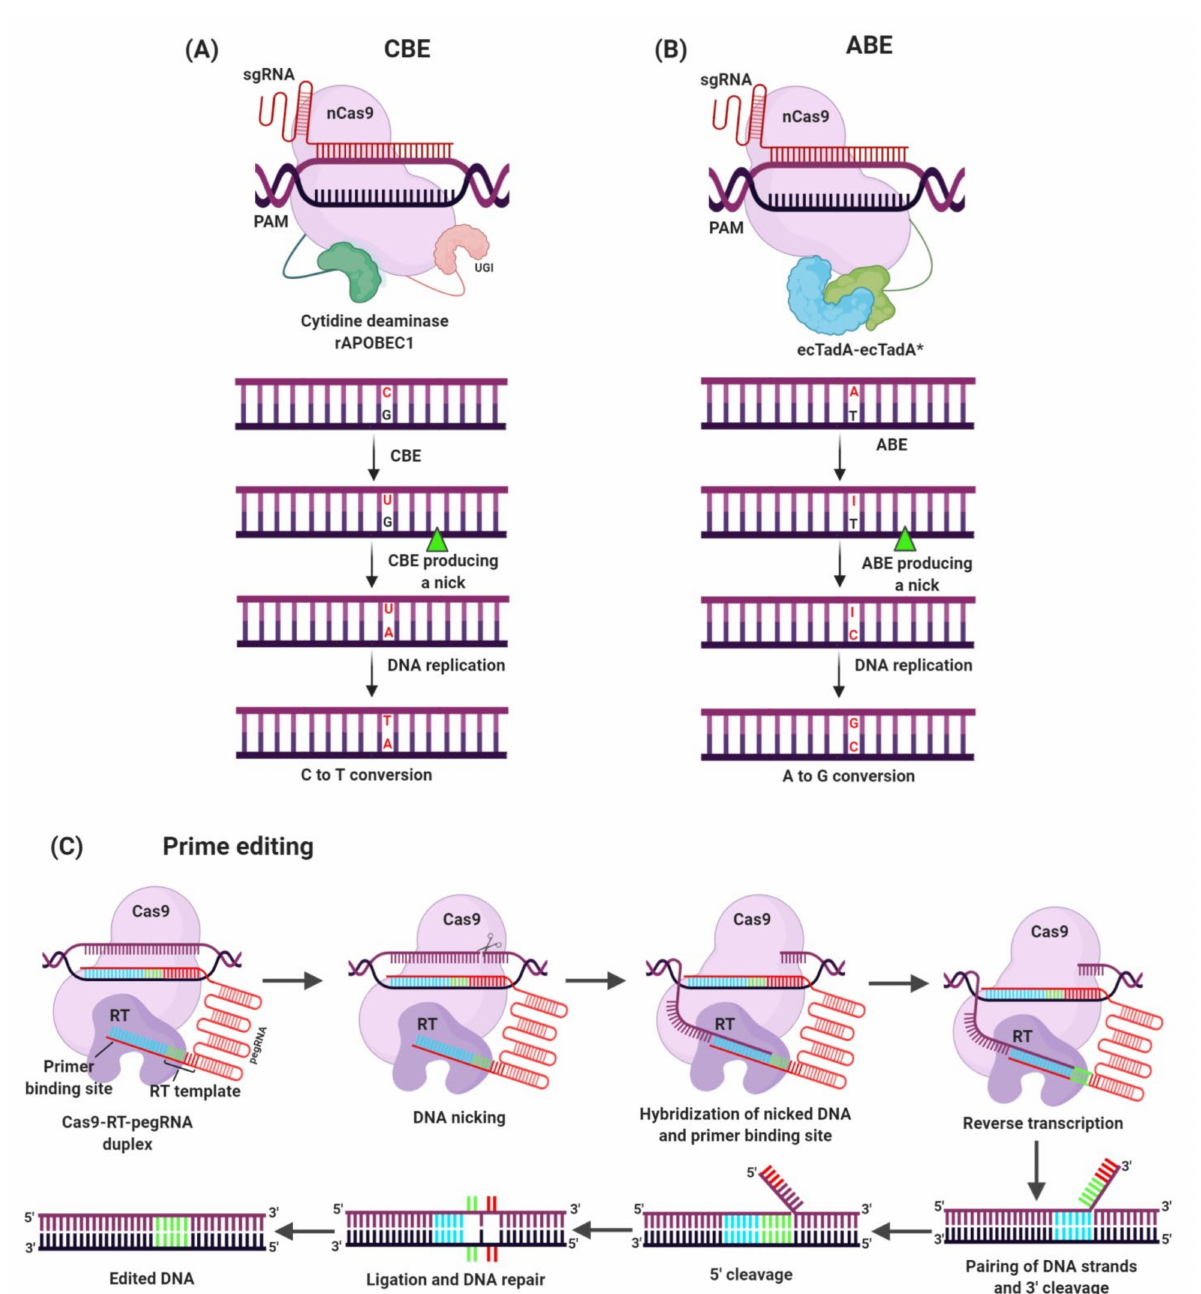
Figure 3. Mechanism of base editing tools. Base editing allows the introduction of precise point mutations by nucleotide substitution at specific target sites in the genome without the need of DSBs. ( A ) Cytidine deaminase base editing (CBE) is fused to an APOBEC1 cytidine deaminase that changes C-G to T-A base pair at the target loci. ( B ) Adenine deaminase base editing (ABE) is fused to an adenine deaminase that changes A-T to G-C base pairs at the target loci. ( C ) Prime editing is a newly developed base editing system enabling precise sequence substitution, insertion, and deletion. The main factor of prime editing is the fusion of nCas9 and reverse transcriptase (RT). The prime editing gRNA encodes desired edits, guiding nCas9-RT complex to the target gene sequence. The prime editor cleaves the DNA, and the cleaved DNA is hybridized to the primer binding site leading to reverse transcription. Base pairing of 3 (cid:48) or 5 (cid:48) flaps occur followed by DNA ligation and repair which results in DNA